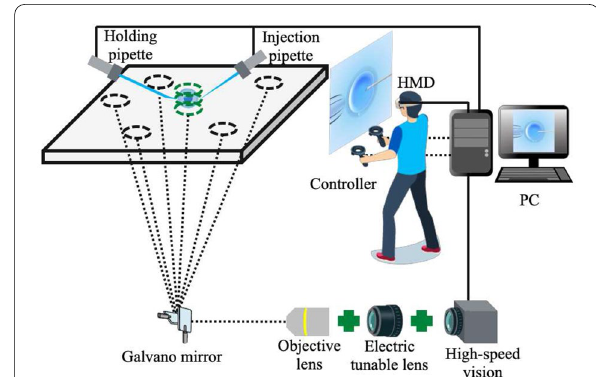
Fig. 3 Concept of the proposed system